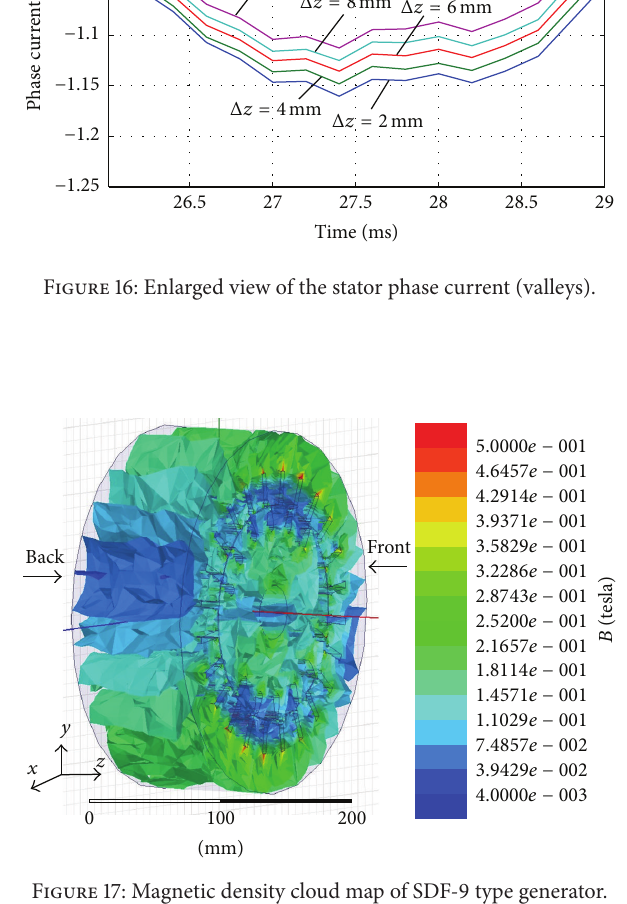
square (RMS) value of (4) and (6). The simulation result is in accordance with the theoretical result based on